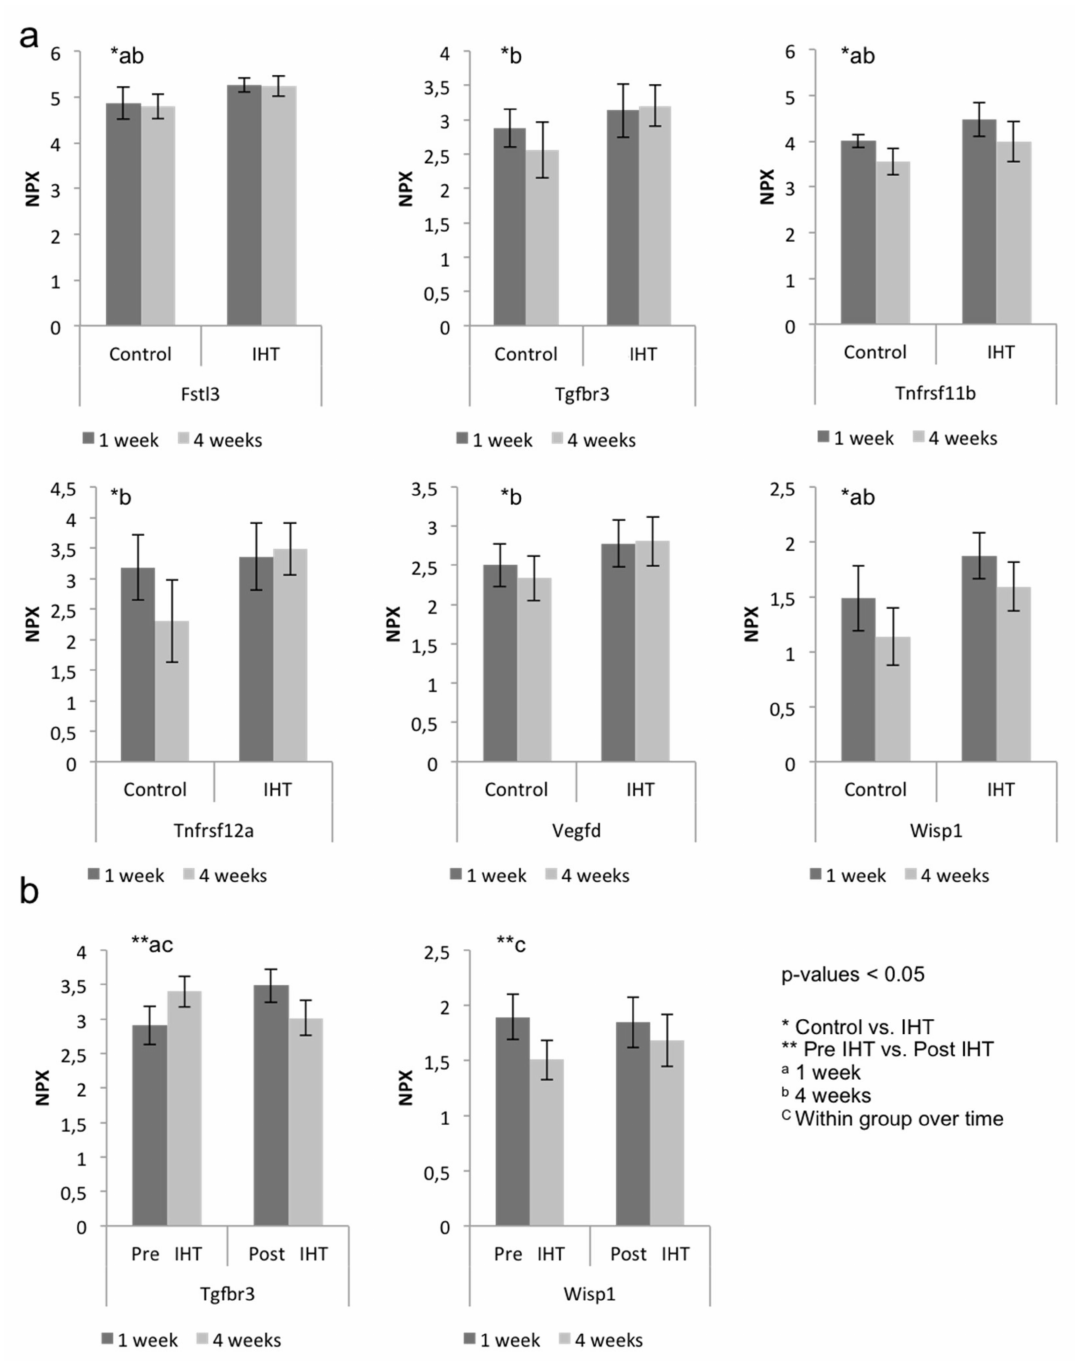
Figure 7. Systemic expression of osteo- and angiogenic proteins. Log2-transformed arbitrary units normalized protein expression (NPX) of selected proteins after 1 and 4 weeks. ( a ) Control compared with Intermittent Hypoxic Therapy (IHT). Osteogenic and angiogenic factors were regulated using IHT, and differences were observed over time. Vertical axes represent NPX values. Horizontal axes represent treatment groups visualized over time. n = 12, biological independent samples. ( b ) pre IHT compared with post IHT. In particular, Tgfbr3 was upregulated at post IHT and within the same IHT but over time. Vertical axes represent NPX values. Horizontal axes represent treatment groups visualized over time. n = 6, biological independent samples. Statistical analysis was performed using one-way ANOVA or the Kruskal–Wallis rank test. Data are presented as unadjusted NPX data, * control compared with IHT or ** pre IHT compared with post IHT. a 1 week and b 4 weeks. p -values < 0.05 were considered statistically